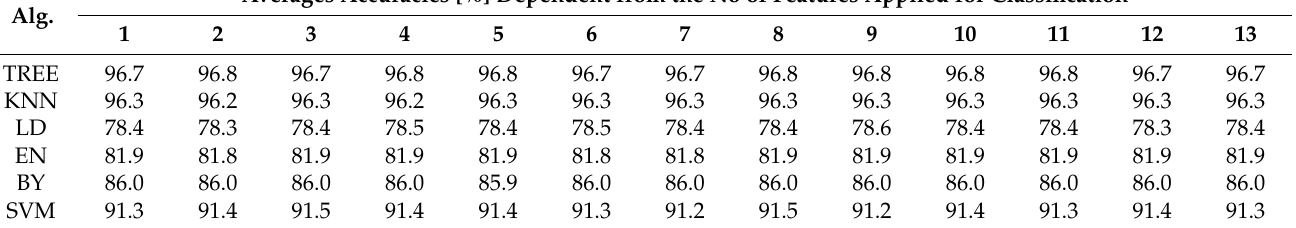
Table 6. Average over accuracies calculated while using various No of